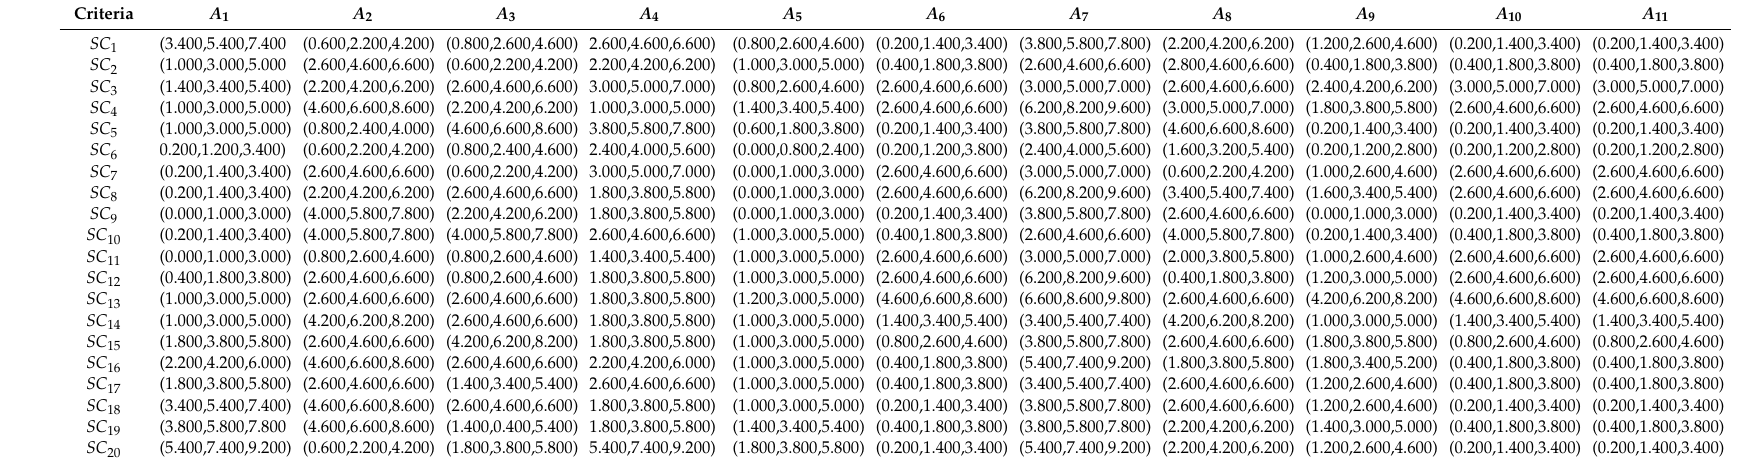
Table 3. The fuzzy decision matrix of sustainable siliceous materials alternatives.